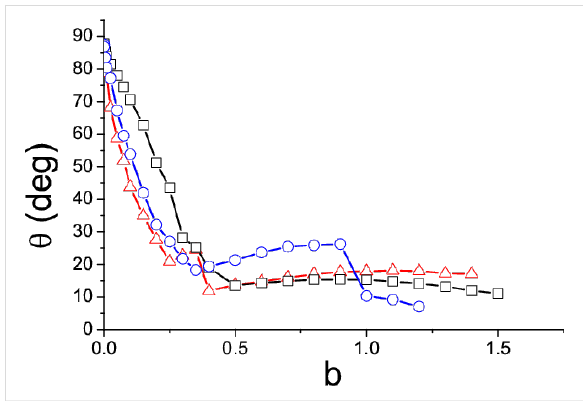
Figure 3: Angle of motion θ of 2 k -branched symmetric islands as a function of the distance b be tween consecutive scan lines (in units of the length parameter a in the text). k = 2 (squares), k = 3 (circles) and k = 4 (triangles).